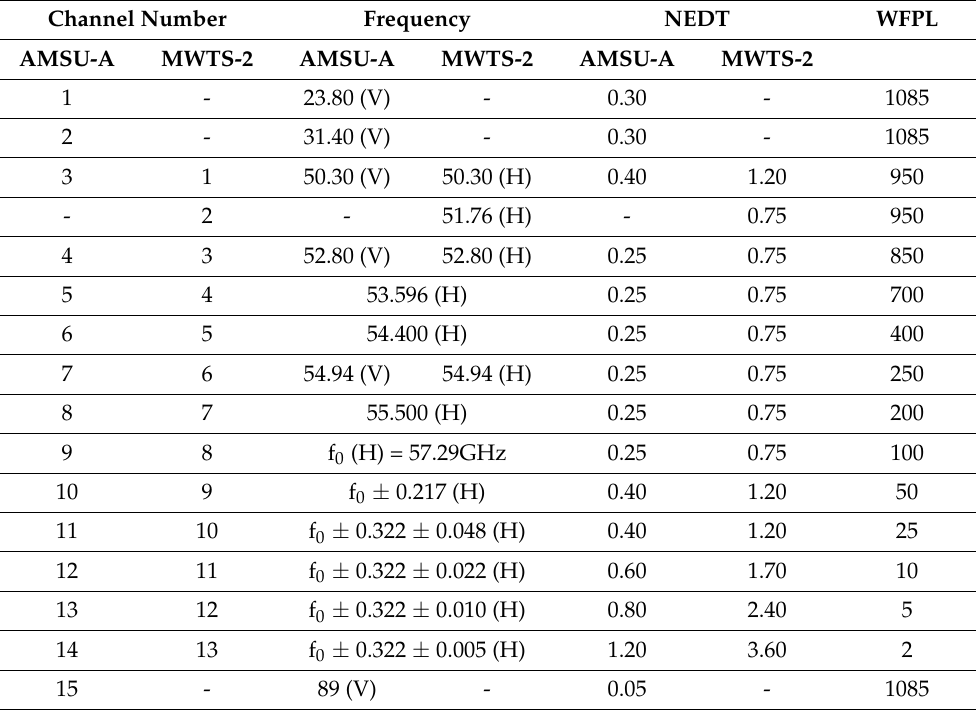
Table 1. Channel number, center frequency (GHz), noise equivalent differential temperature (NEDT, unit: K), and weighting function peak level (WFPL, unit: hPa) of AMSU-A and MWTS-2. Horizontal (H) or vertical (V) polarization is indicated in brackets.